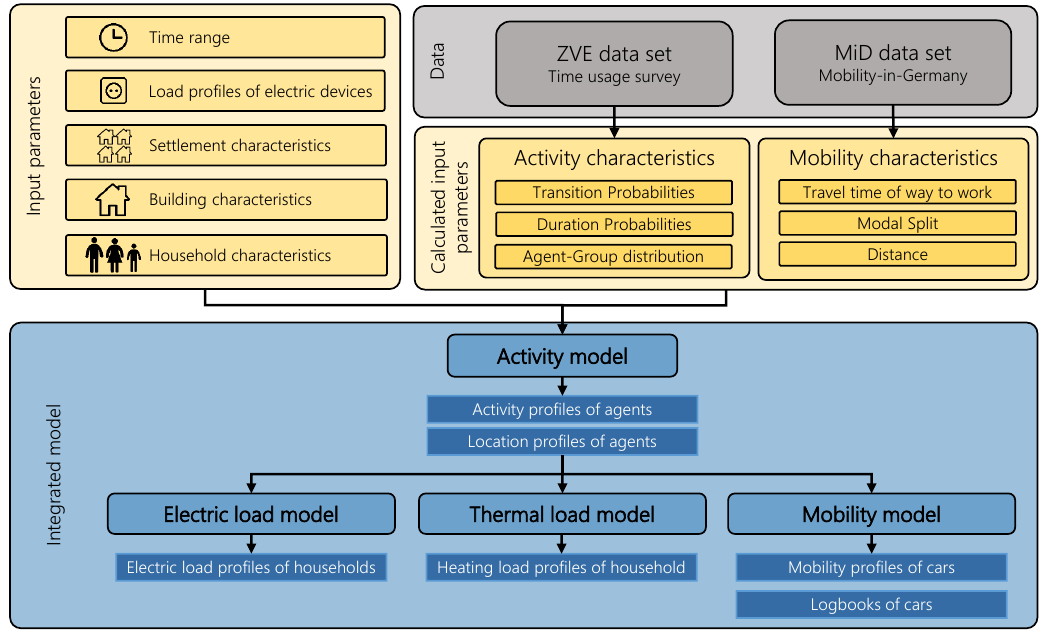
Figure 1. General overview of the model.